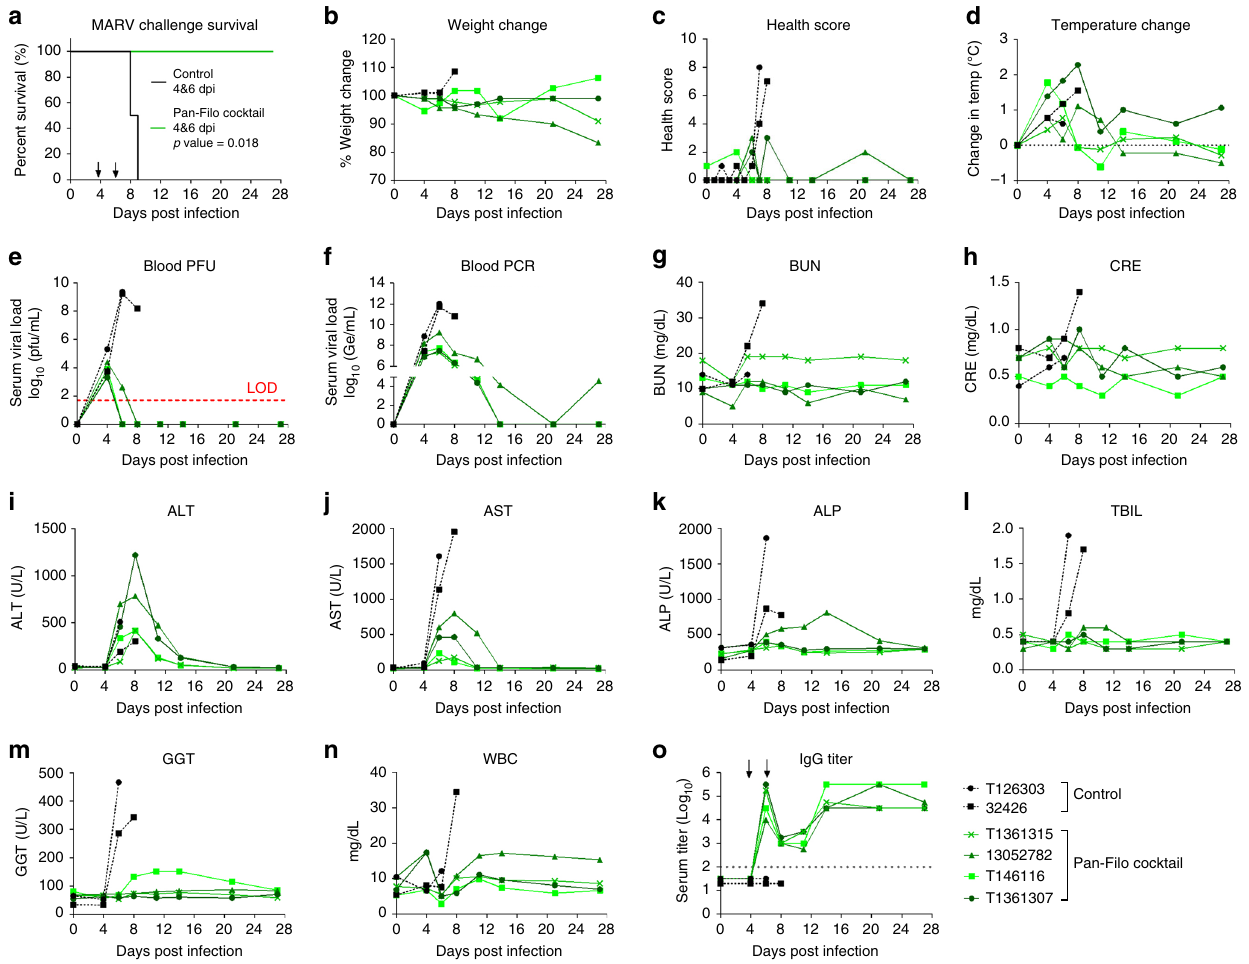
Fig. 4 Ef fi cacy of PF cocktail against MARV infection. Rhesus macaques were infected with MARV (Ci67) and treated with the PF cocktail ( n = 4) at 4 and 6 dpi. Survival ( a ) daily health evaluations ( b – d ), viremia by plaque assay (limit of detect of 50 pfu/mL) ( e ) and RT-qPCR ( f ), blood chemistry ( g – m ), white blood cells ( n ), and serology data ( o ) are shown. CRE creatine, AST aspartate transaminase, ALP alkaline phosphatase, GGT gamma-glutamyl transferase, WBC white blood cells. Statistical analysis of survival was performed by log-rank